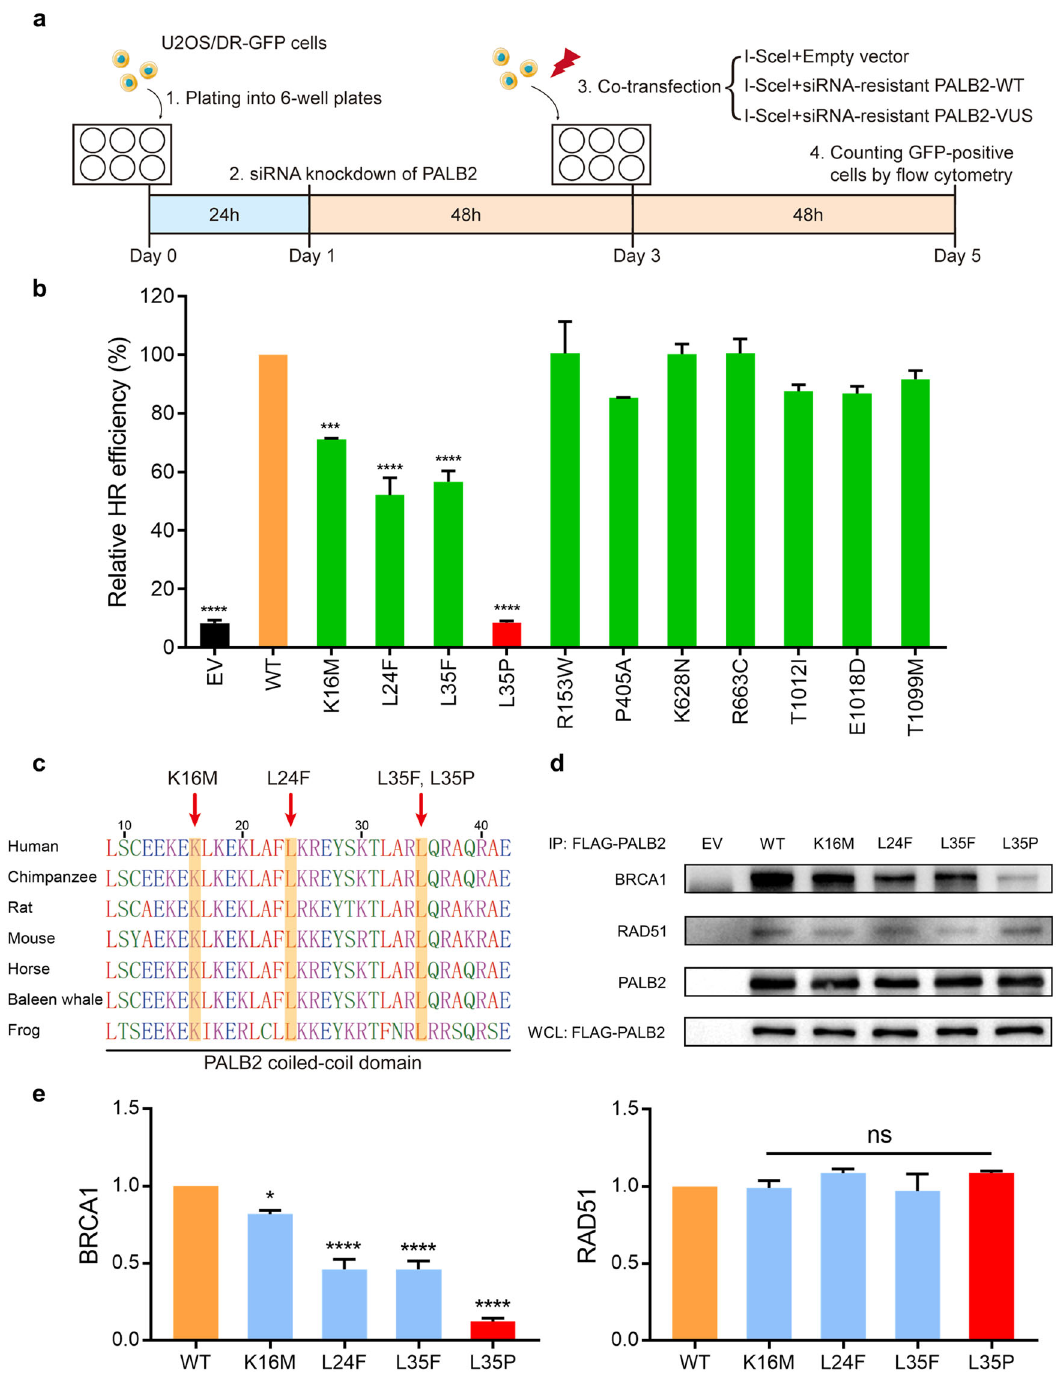
Fig. 2 Effects of PALB2 VUSs on HR activity and BRCA1 interaction. a Schematic representation of the HR repair assay used in our study. b HR activity of the selected PALB2 VUSs. PALB2-knockdown U2OS/DR-GFP cells were co-transfected with an I-SceI expression vector and the siRNA-resistant PALB2 constructs (or an empty vector, EV). Data represent the mean percentage ( ± SEM) of GFP-positive cells relative to the WT condition from three independent experiments. Statistical signi fi cance was analyzed by one-way ANOVA and Dunnett ’ s multiple comparisons test. *** P < 0.001; **** P < 0.0001. c Amino acid sequence alignment of the PALB2 coiled-coil domain from various species. PALB2 VUSs that signi fi cantly impaired the HR activity were marked on the top. d The PALB2 VUSs disrupted BRCA1-PALB2 interactions. The indicated FLAG-tagged PALB2 constructs (or an empty vector, EV) were transiently transfected in 293 T cells, and PALB2 proteins were immunoprecipitated with anti-FLAG M2 beads. PALB2-binding proteins were analyzed by western blotting. Whole cell lysate (WCL) showed levels of PALB2 expression. e Quanti fi cation of western blotting band intensities ( d ) from three independent experiments. BRCA1 and RAD51 protein expressions were normalized to PALB2 protein levels and compared to the WT condition. Data presented as mean ± SEM. Statistical signi fi cance was analyzed by one-way ANOVA and Dunnett ’ s multiple comparisons test. * P < 0.05; **** P < 0.0001; ns, not signi fi